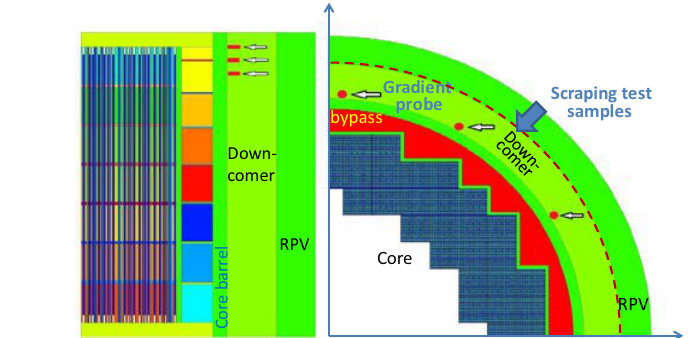
Figure 4. An illustration on the experimental data available for the FNF predictions validation.